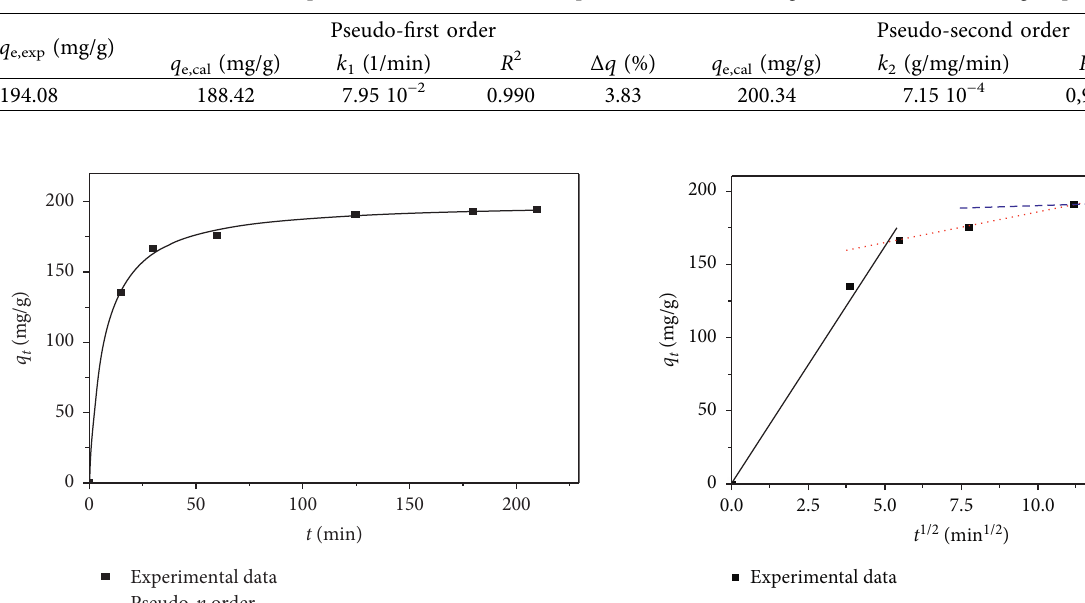
Table 2: Pseudo- n -order kinetic parameters ( C q e,exp (mg/g)